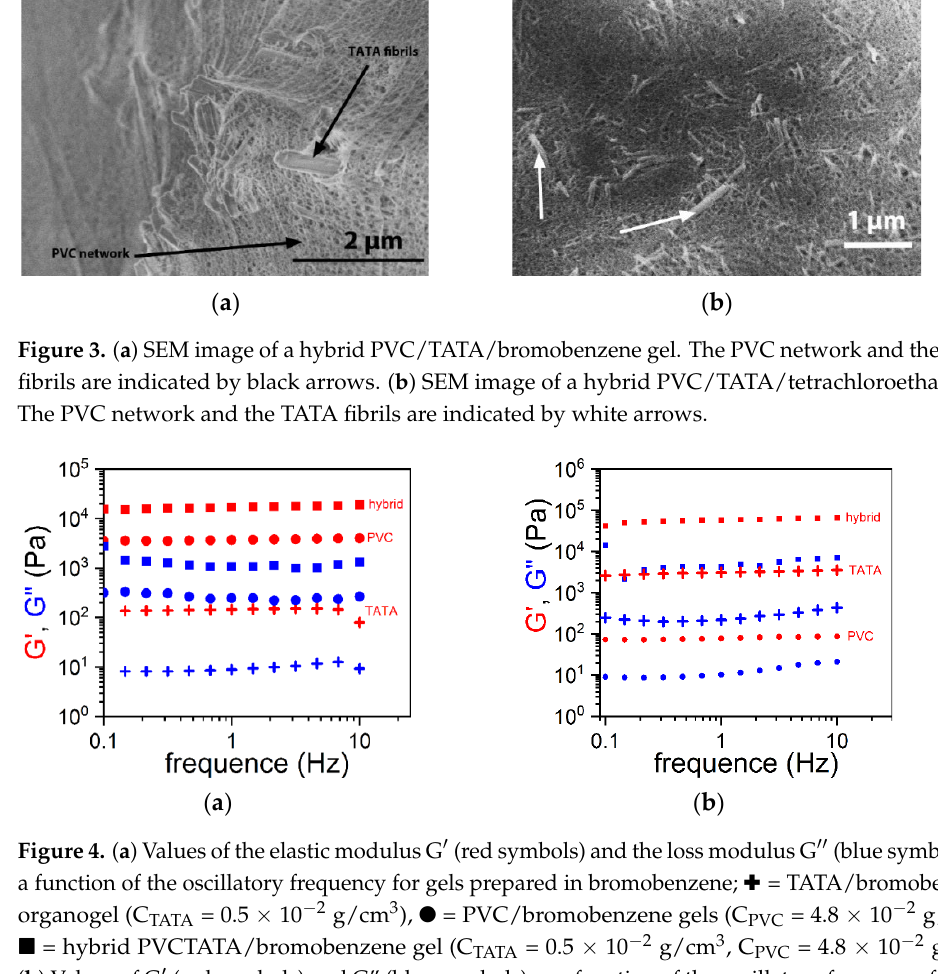
Figure 3. ( a ) SEM image of a hybrid PVC/TATA/bromobenzene gel. The PVC network and the TATA fibrils are indicated by black arrows. ( b ) SEM image of a hybrid PVC/TATA/tetrachloro- ethane gel. The PVC network and the TATA fibrils are indicated by white arrows.